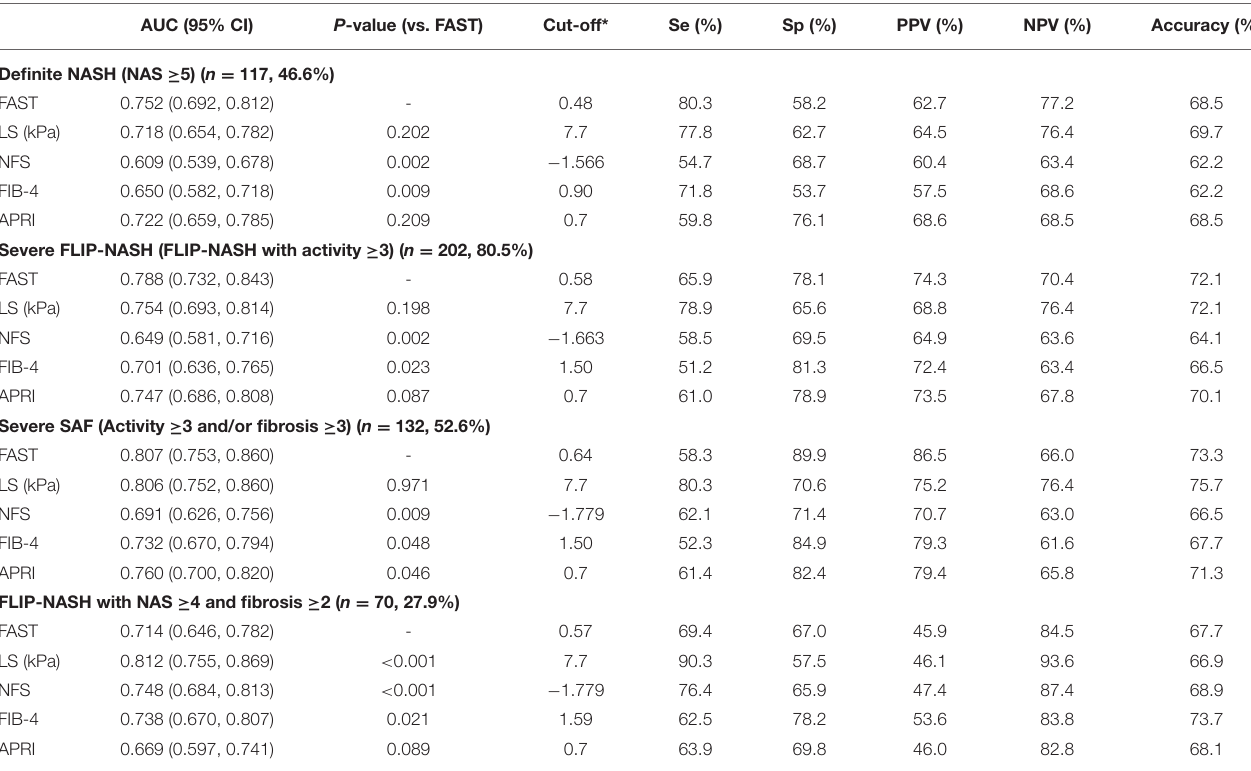
TABLE 4 | Diagnostic accuracy of non-invasive surrogates in predicting high-risk NASH. AUC (95% CI) P -value (vs. FAST) Cut-off* Se (%) Sp (%) PPV (%) NPV (%) Accuracy (%) Definite NASH (NAS ≥ 5) ( n = 117, 46.6%)